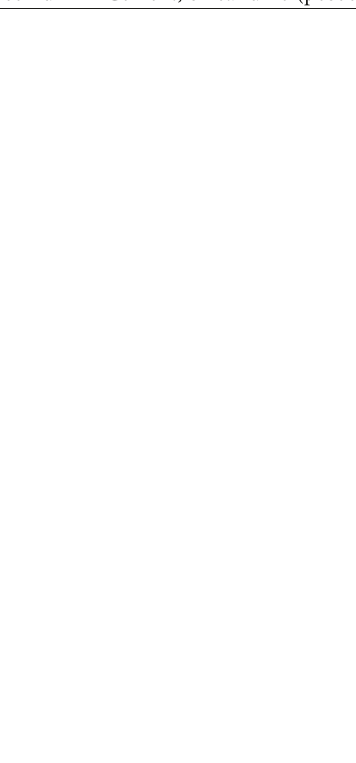
Figure 2: Bending test setup. Table 11: The list of UHPC beam